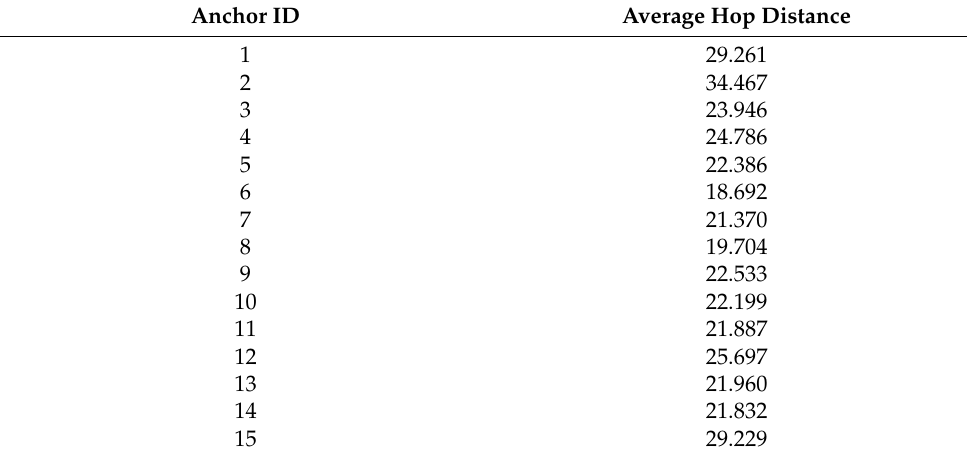
Table 3. Average hop distance of all anchors.